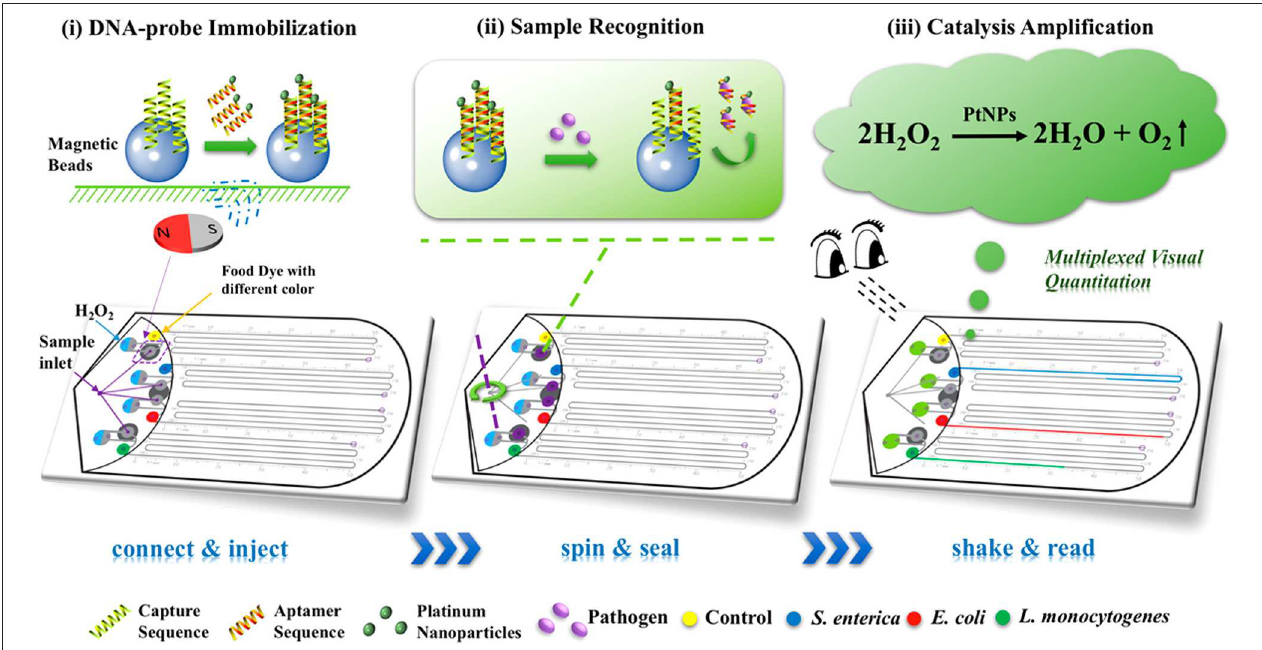
FIGURE 5 | Schematic diagram of the multiplexed instrument-free bar-chart SpinChip integrated with nanoparticle mediated magnetic aptasensors for quantitative visual detection of multiple pathogens including S. enterica , E. coli , and L. monocytogenes . Reprinted (adapted) with permission from Wei X. et al. (2018). Copyright (2018) American Chemical Society. Permission has been obtained from American Chemical